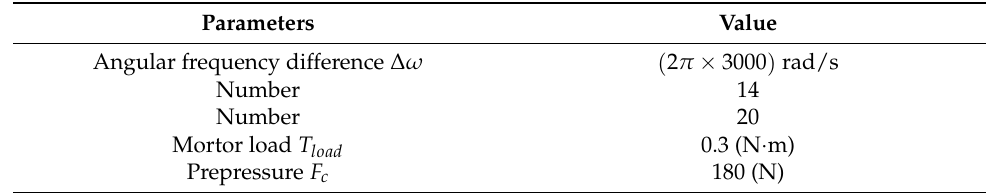
Table 3. Parameter setting table.